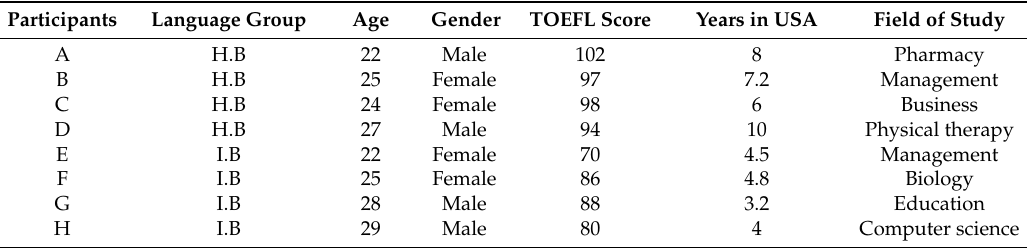
Table 4. Participants’ background